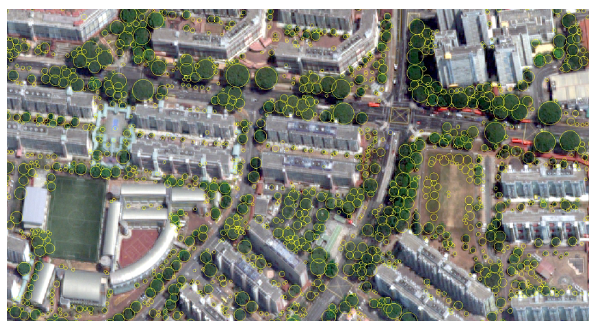
Figure 4. Tree crowns extracted from satellite imagery